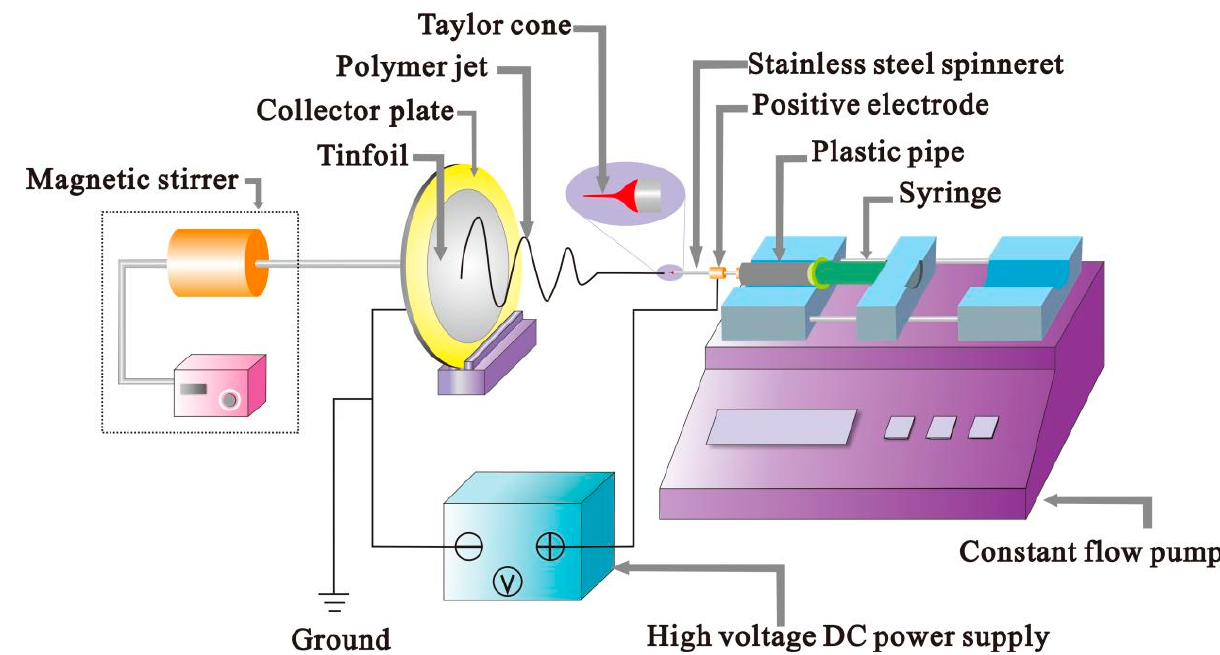
Figure 1. Connection diagram of electrostatic spinning equipment.